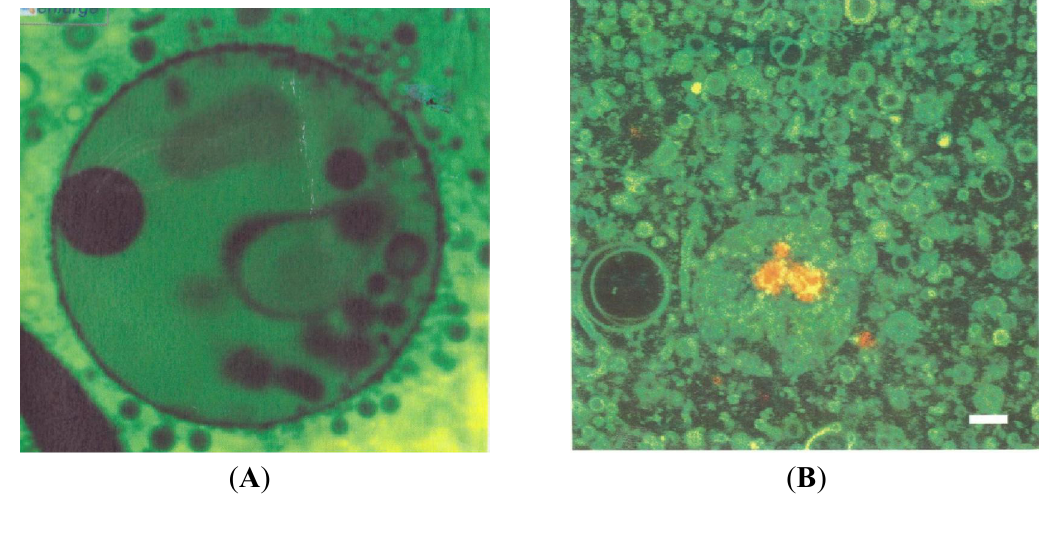
Figure 7. Comparison of a Clay-Armored Vesicle ( A ) with a Lipid Vesicle ( B ). ( A ) Fatty acid liposomes inside a clay-armored vesicle, 100 microns in diameter Photo courtesy of Dr. Amand Abala Subramaniam, Harvard School Engineering and Applied Sciences. ( B ) Red-tagged RNA molecule bound to montmorillonite encapsulated in a non-armored vesicle with a diameter of five microns. Photo courtesy of Dr. M. Hanczyc, Howard Hughes Medical Institute and Department of Molecular Biology, Mass. General Hospital, Boston, Mass. Tessera [20] traces the emergence of vesicles with bilayer membranes composed of a mixture of amphiphilic and hydrophobic molecules and their possible evolution. Bar scale is one